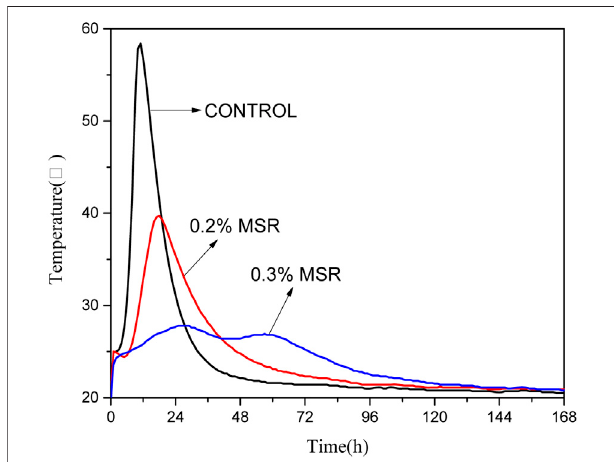
FIGURE 5 | Semi-adiabatic temperature rise of cement paste.